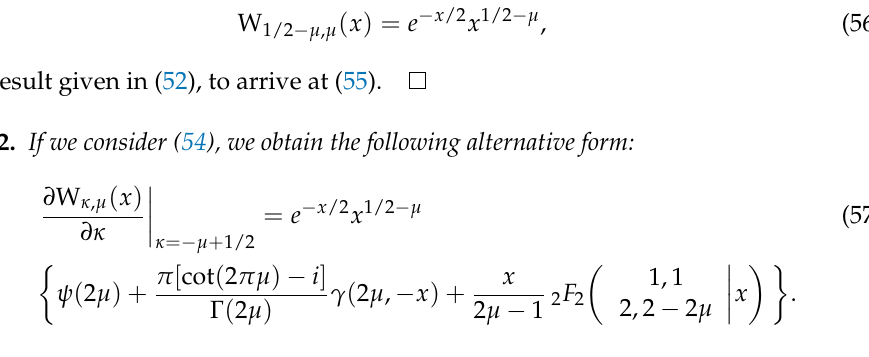
Table 5. Derivative of W κ , µ with respect to κ , by using (57).